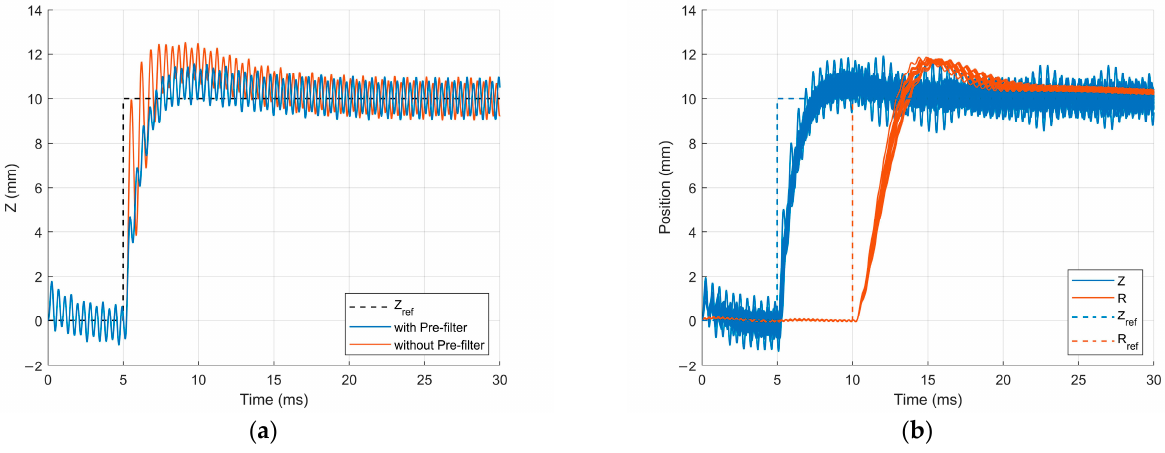
Figure 7. ( a ) Step responses of the vertical plasma position in the system with and without the pre- filter. Overshot is decreased from 29% to 17%, setting time is decreased from 7 ms to 5 ms; ( b ) set of 18 step responses of the vertical and horizontal plasma control systems with different plasma mod- els.